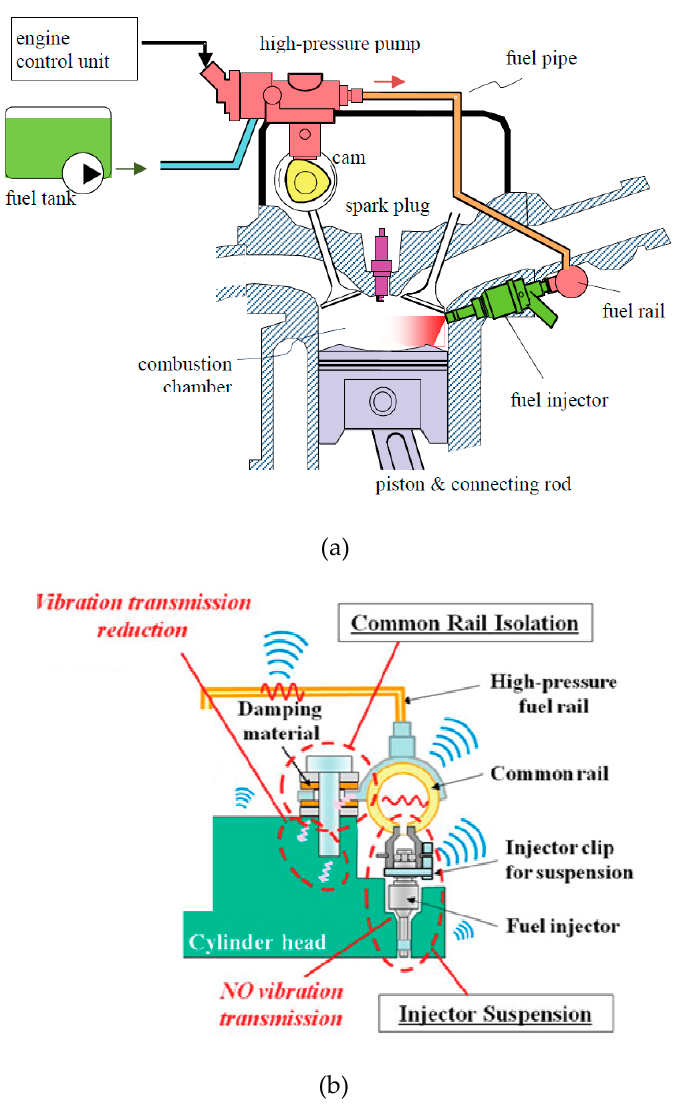
Figure 6. Schematics of ( a ) gasoline direct injection fuel system; ( b ) rail isolation and injector suspension [23]. Figures are reprinted with permission from publisher. suspension [23]. Figures are reprinted with permission from